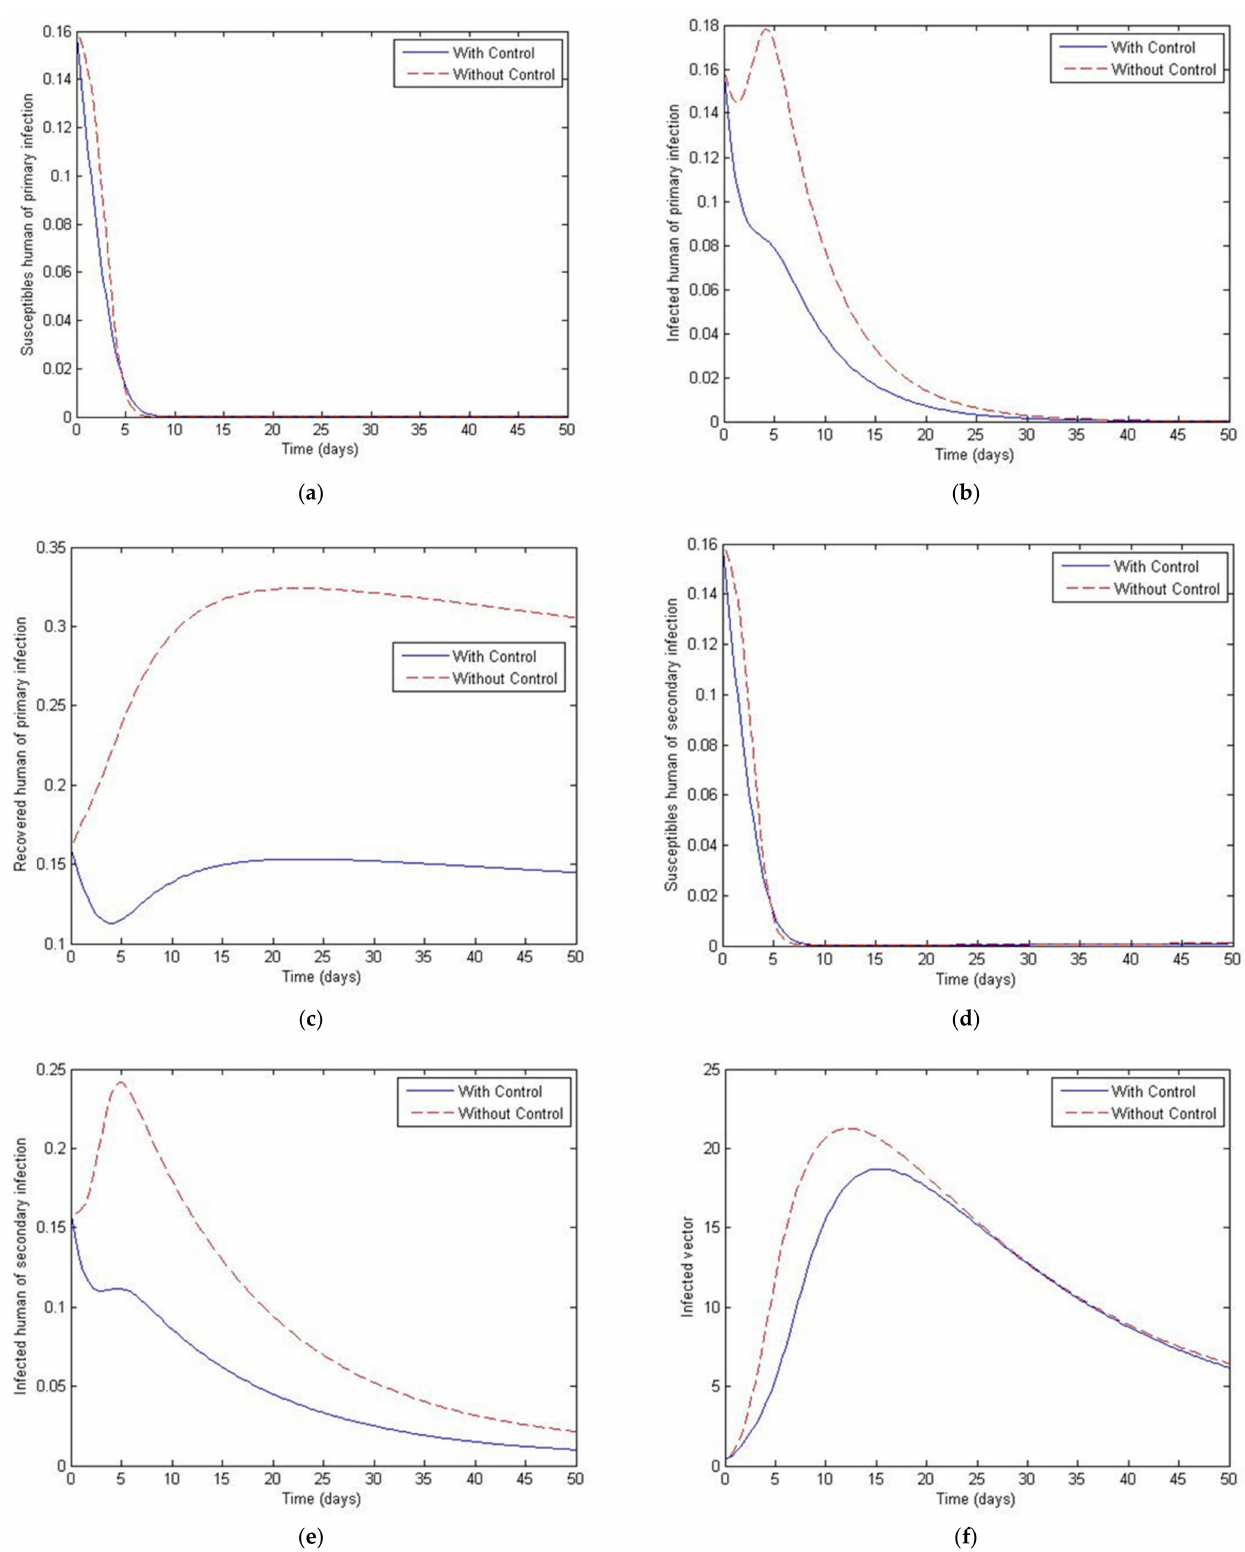
Figure 13. Simulation results of system of Equations (38)–(43) with and without controls of S HP , I HP , R HP , S HS , I HS and I V when X 1 = 0.00001, X 2 = 100. ( a ) Susceptibles of primary infection ( b ) Infected population with primary infection ( c ) Recovered human of primary infection ( d ) Susceptibles of secondary infection ( e ) Infected human of secondary infection ( f ) Infected